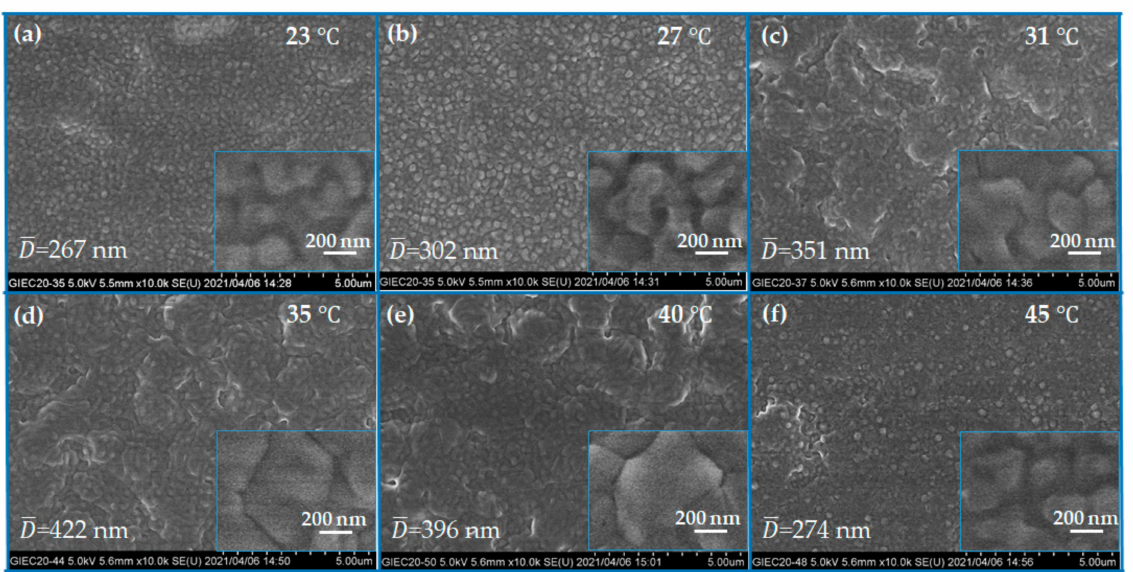
Figure 3. SEM images of CsPbI 2 Br perovskite films spin-coated at different ambient temperatures: ( a ) 23 ◦ C; ( b ) 27 ◦ C;